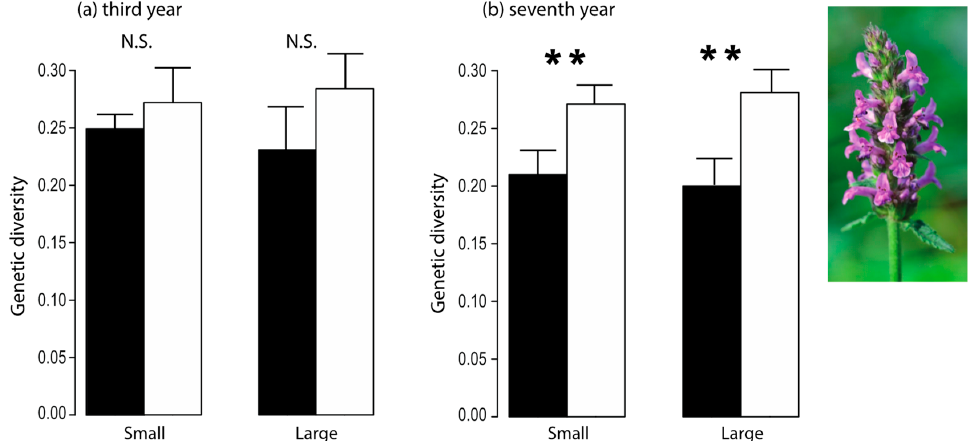
Figure 9. Genetic diversity [99] of S. officinalis -seedlings in small and large fragments (black bars) and the corresponding control plots (open bars) in the ( a ) third year and ( b ) seventh year of experimental fragmentation. Means ± SE are shown; n = 7; ** p < 0.01; N.S. not significant. Data from Rusterholz and Baur [41].